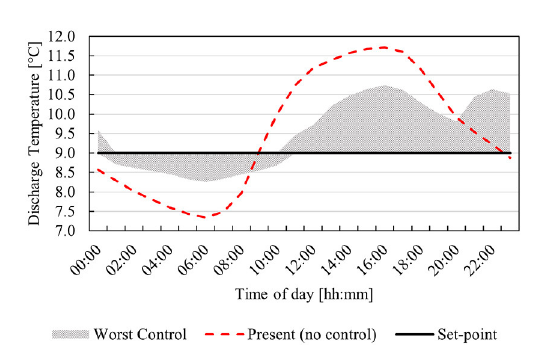
FIGURE8 Comparison of worst simulated control- and present discharge temperature for an average day’s ambient conditions.